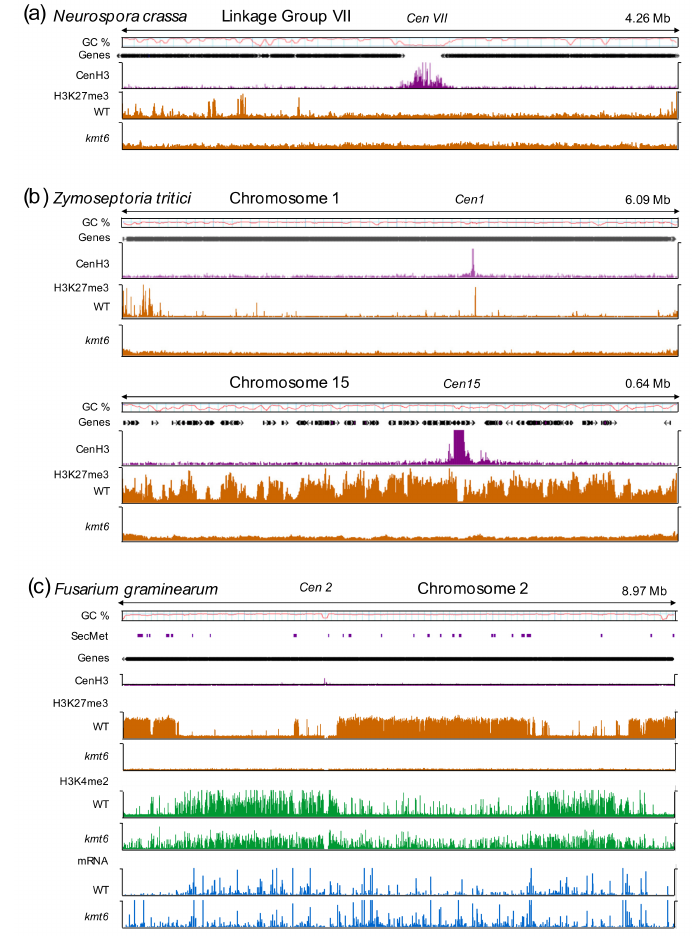
Figure 1. Chromatin landscapes in selected filamentous fungi . ( a ) In N. crassa , H3K27me3 covers subtelomeric regions and discrete interstitial sequences along the chromosome arms. Deletion of kmt6 results in complete loss of H3K27me3. ( b ) H3K27me3 enrichment in Zymoseptoria tritici di ff ers